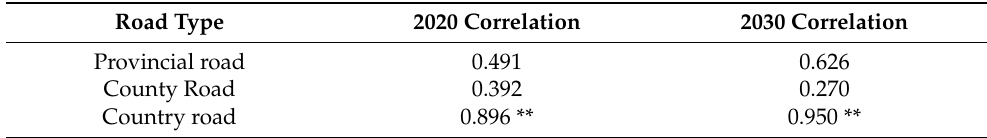
Table 6. Correlation analysis between PWD area and road